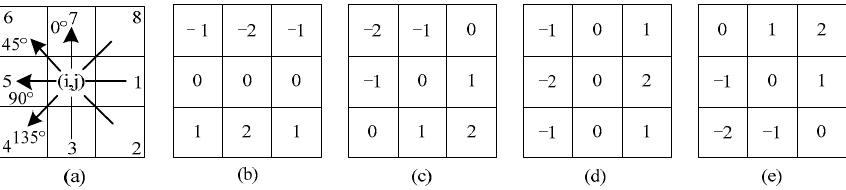
Figure 4. ( a ) Neighborhood pixels and gradient directions. the numbers 1–8 indicate the 8 neighbor- hood pixels of the central pixel (i, j) in turn, and 0°, 45°, 90°, and 135° respectively indicate the four gradient directions. ( b – e ) are the convolution templates corresponding to the four directions.